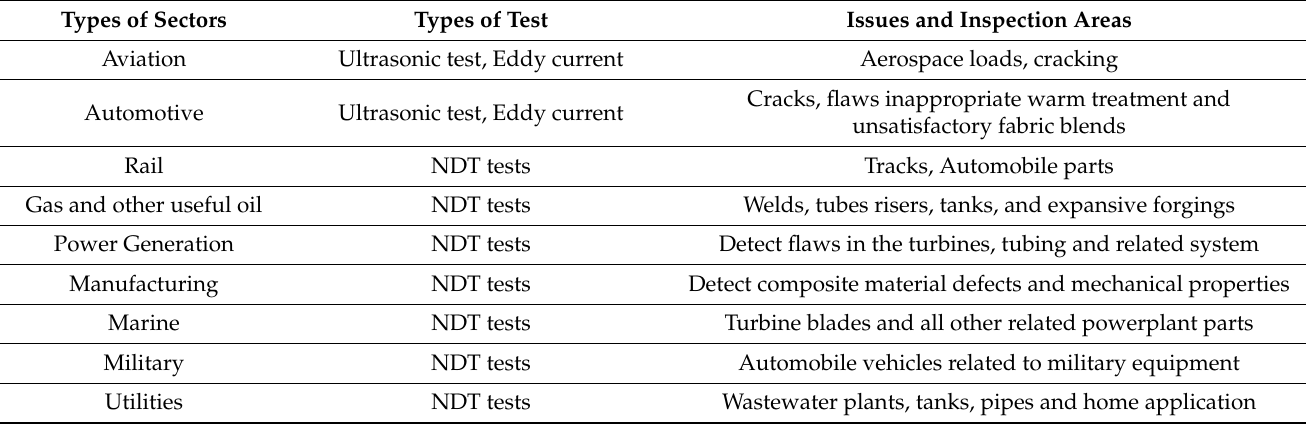
Table 3. Types of industrial sectors using nondestructive testing